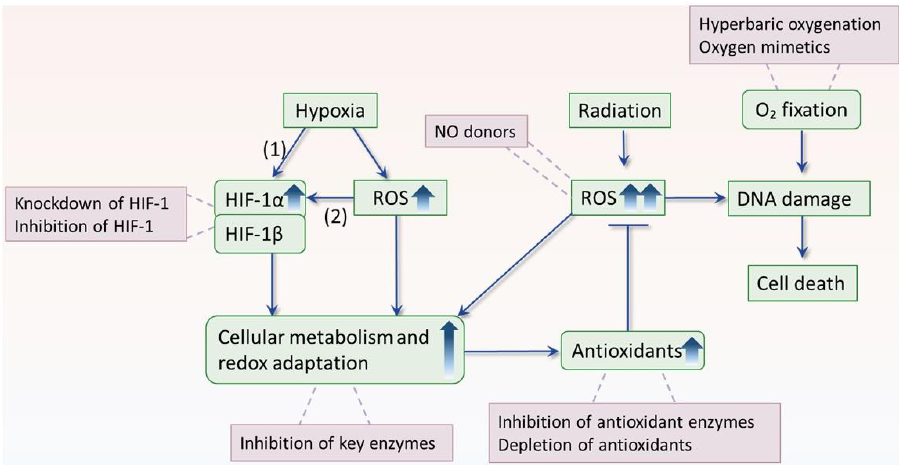
Figure 3. The interplay among hypoxia, ROS and radiation, and strategies to overcome hypoxic radioresistance. Radiotherapy kills cancer cells by causing DNA damage via generation of reactive oxygen species (ROS). However, under hypoxic condition, hypoxia induces HIF-1 α accumulation by (1) prevention of protein degradation, or (2) upregulation of gene expression via ROS mediated pathways. As a result of increased HIF-1 α , HIF-1 is activated and regulates more than a hundred of genes, conferring radioresistance by acting upon multiple mechanisms at different levels. For example,